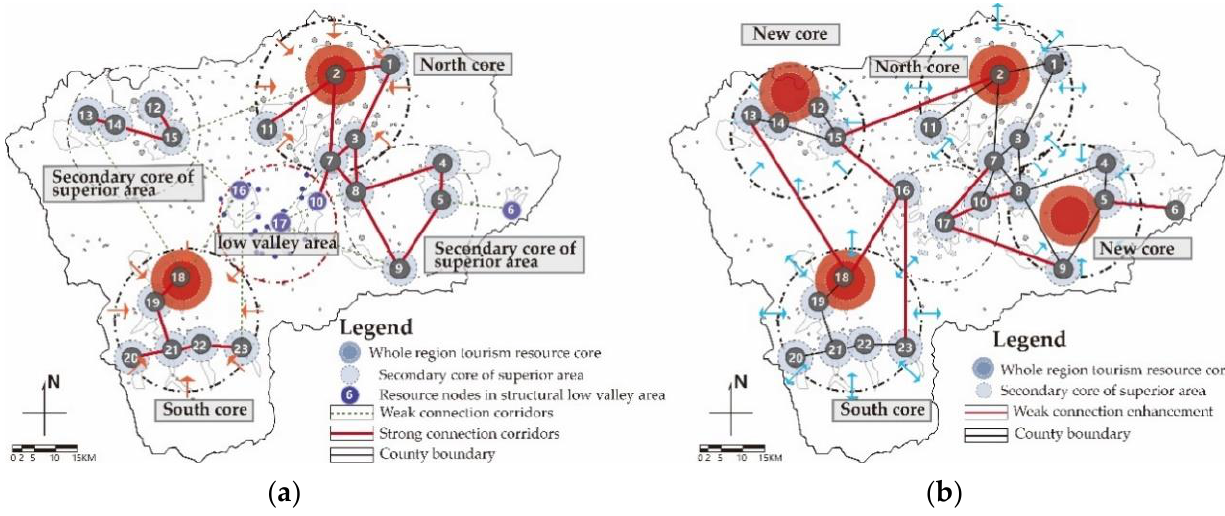
Figure 14. Transformation of the network structure multipole core equilibrium structure: ( a ) existing spatial structure and ( b ) multi-core structure transformation.